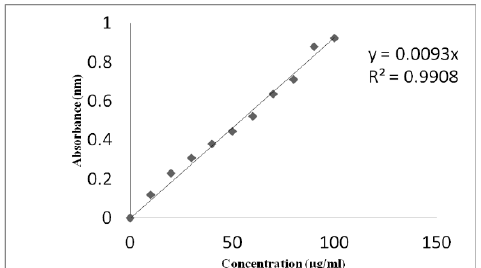
Table 2. Drug polymer interaction (FTIR)